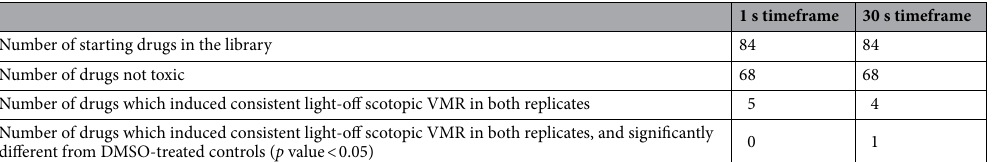
Table 1. Summary of drug-screening results. The 84 drugs in the ENZO Redox library were each applied to the Q344X larvae at 10 μM (N = 24 larvae) in two independent replicates. Of these 84 drugs, 16 were toxic. The two replicates were then compared to each other with a High-Dimensional Nonparametric Multivariate Test to determine similarity in either 1-s or 30-s timeframe. The drugs that induced consistent light-off scotopic VMR were compared to DMSO-treated Q344X controls to determine if they caused a significant change in behavior (High-Dimensional Nonparametric Multivariate Test, p value < 0.05). In the 1-s timeframe, no drugs met all criteria, but in the 30-s timeframe, one drug (carvedilol) was both consistent in the two replicates and caused a significant change in light-off scotopic VMR compared to